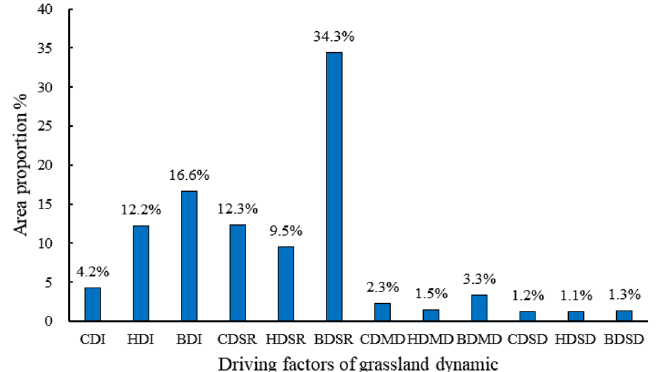
Figure 6. Area proportion of driving factors for grassland degradation and restoration.